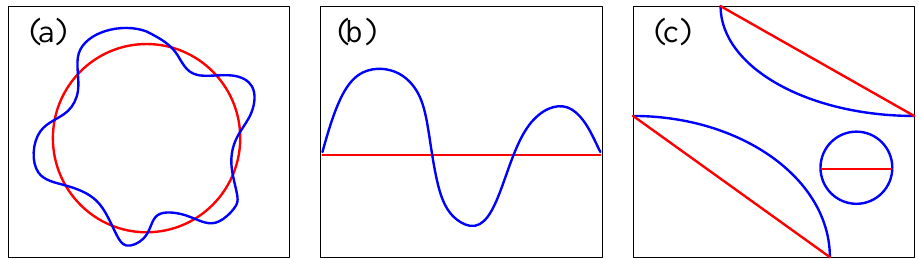
Figure 1. Example of sinuosity calculations for simple hemispheric and complex regional cases. The three different situations that are generally encountered are: ( a ) when the latitudes are closed within the whole northern hemisphere; ( b ) when the latitudes are not closed within a local area; and ( c ) when there is more than one contour line of the same numerical size in a region. The blue lines in the figures indicates a geopotential height contour at 500hPa, and the red lines indicates the latitude .